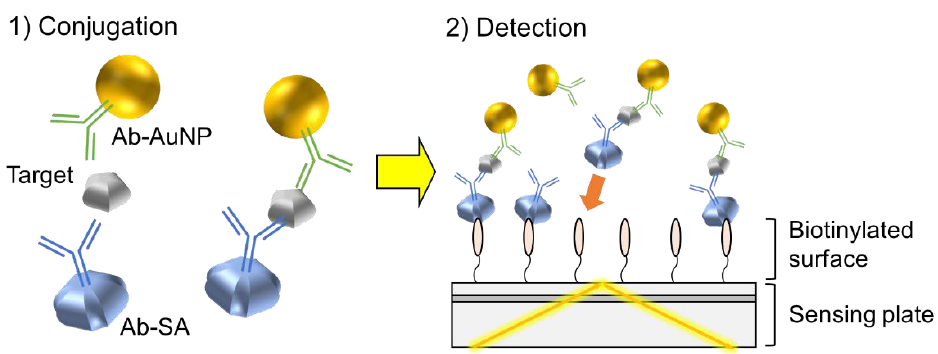
Figure 1. Detection scheme of one-step method. Ab-AuNP: gold nanoparticle-conjugated antibody; Ab-SA: streptavidin-conjugated antibody.